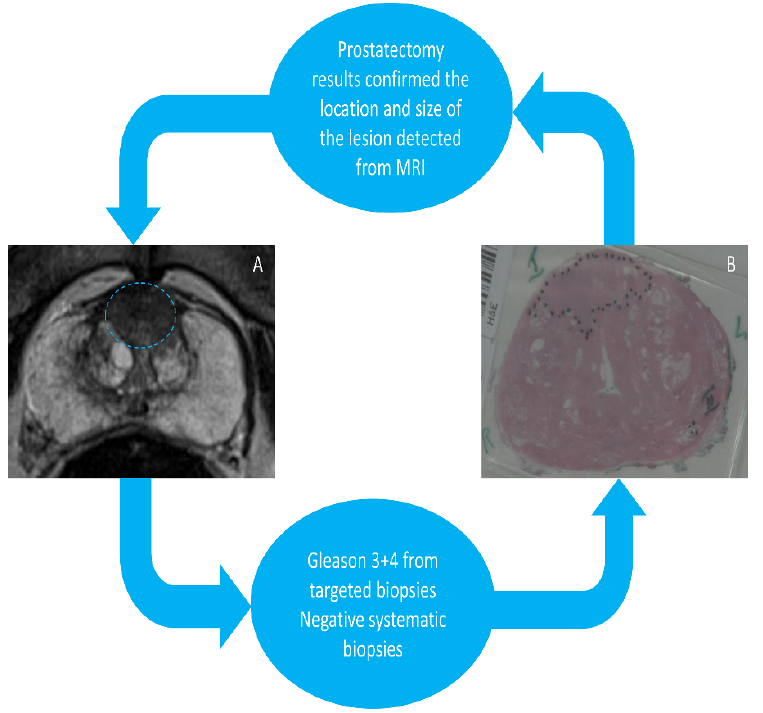
Figure 1. ( A ) A 76-year-old patient with a PIRADS 5 lesion detected from 3T MRI in anterior zone with a high PSA and abnormal DRE. ( B ) Patient-specific 3D mould-based grossing of a radical pros- tatectomy slice shows a 3 + 4 GS cancer located in the anterior